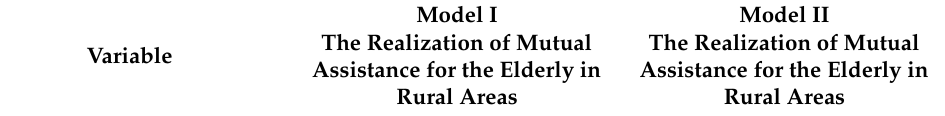
Table 5. The impact of bonding social capital, bridging social capital, and linking social capital on the realization of mutual assistance for the elderly in rural